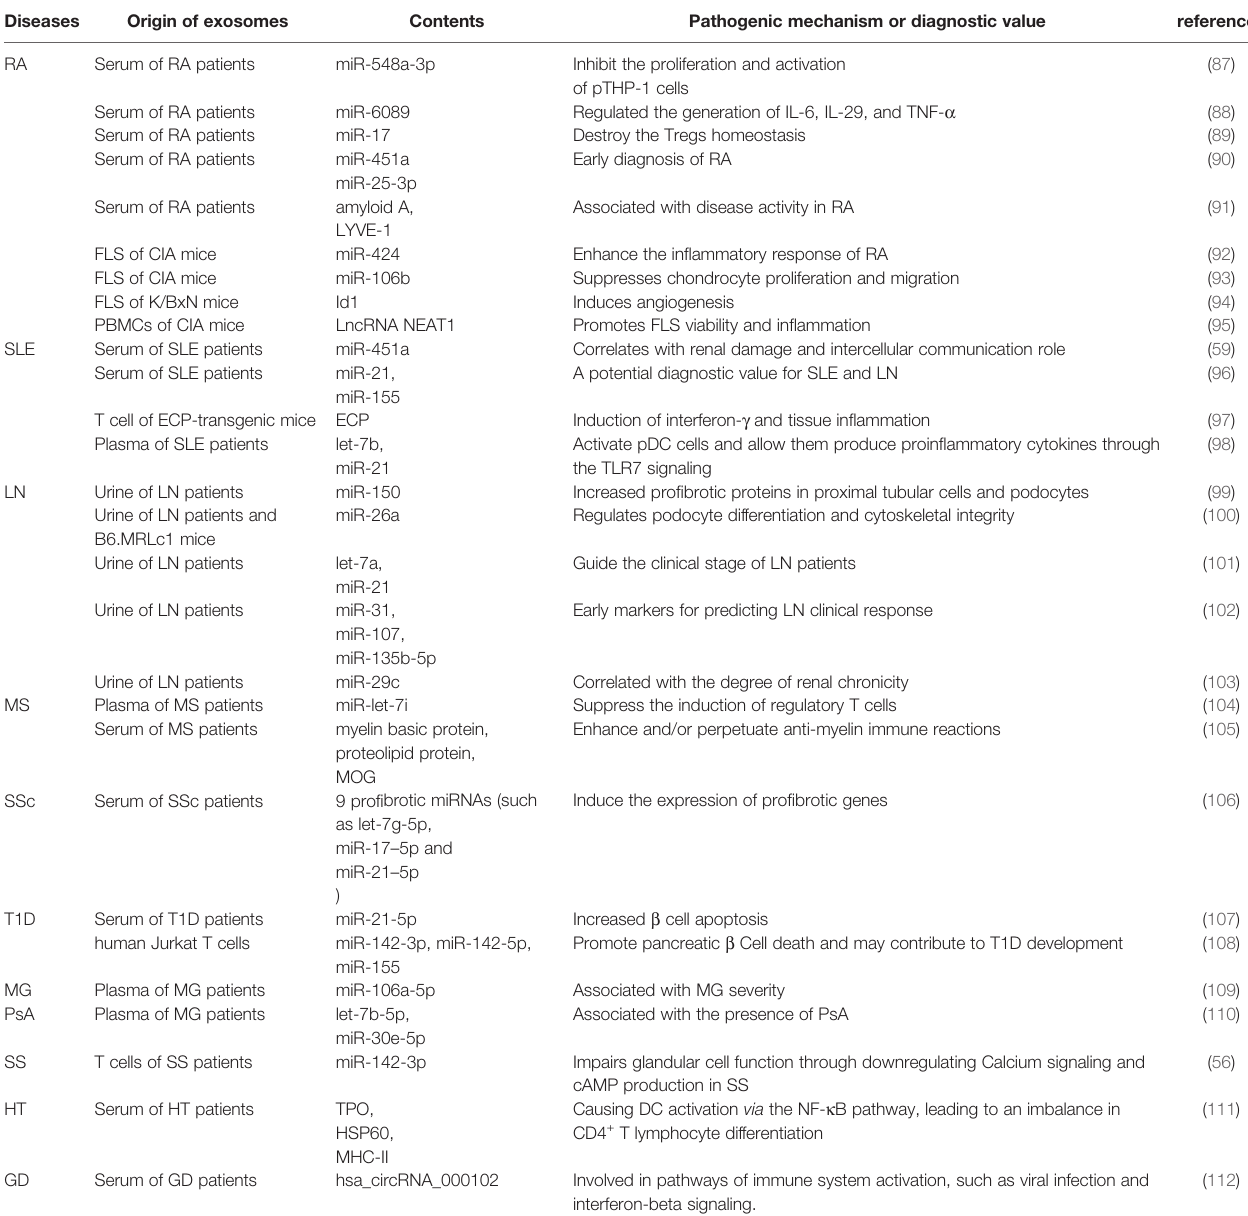
TABLE 7 | The contents of endogenous exosomes in the pathogenesis or diagnosis of